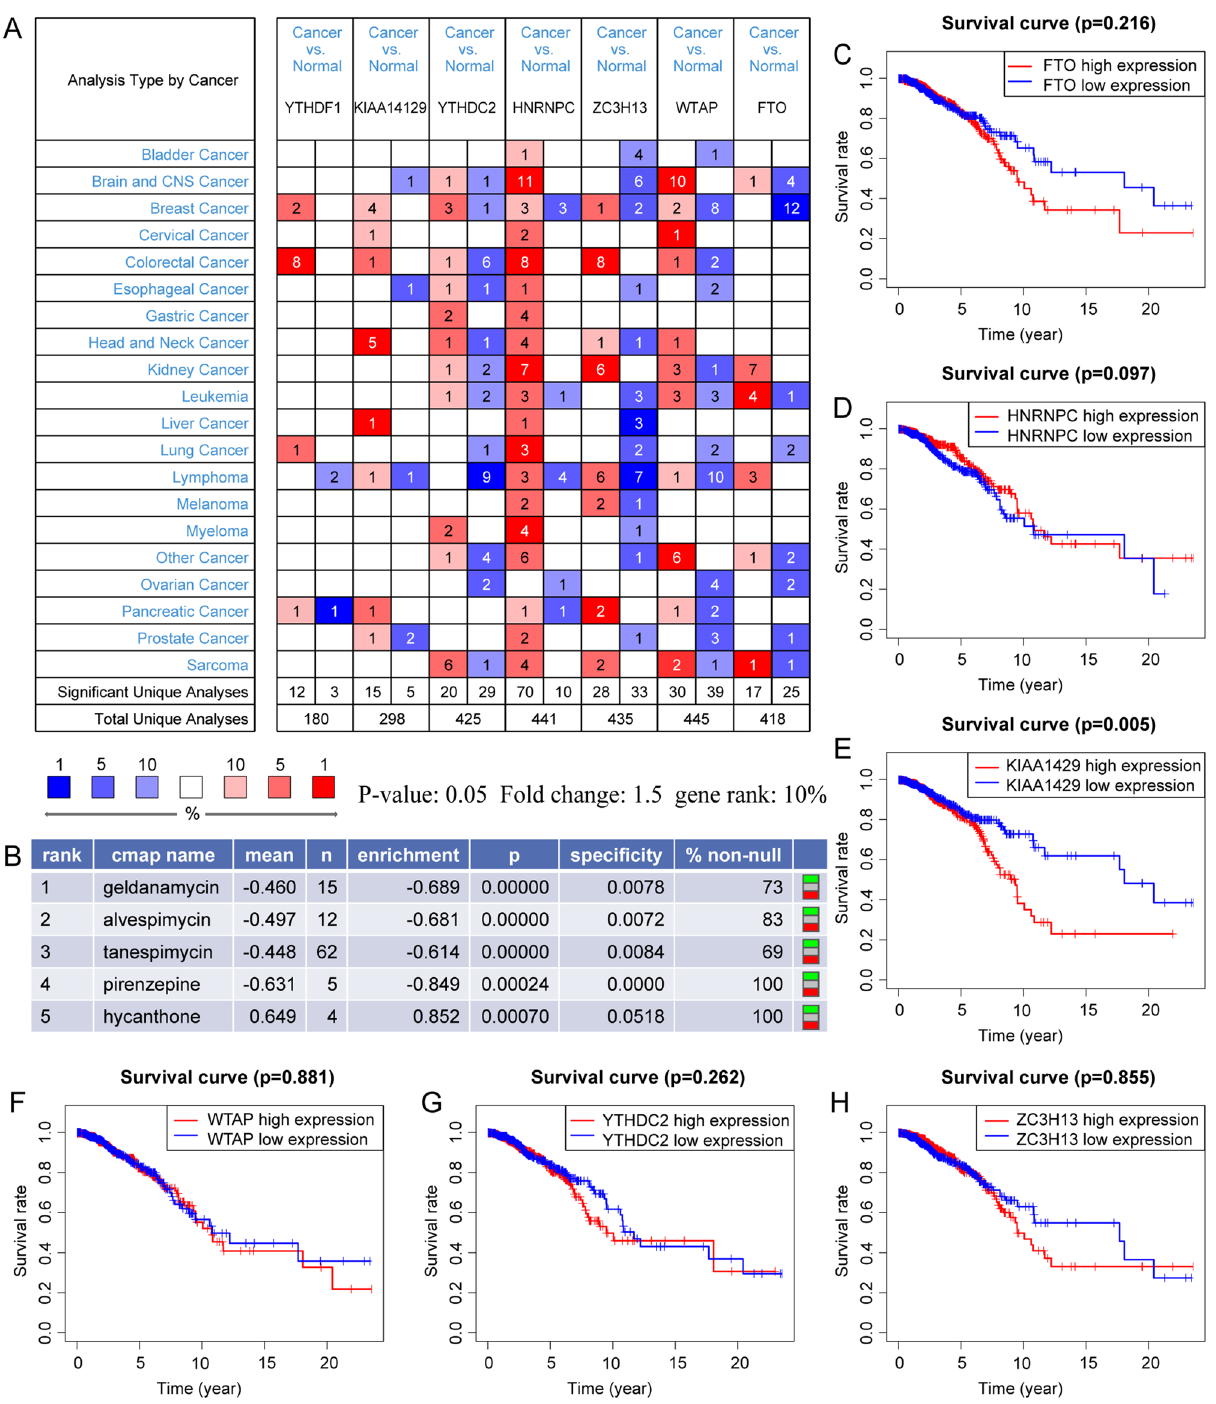
Figure 5. Clinical and pan-cancer characters of m6A regulators. ( A ) The expression of seven prognostic m6A regulator genes of BC in pan-cancer. ( B ) five potential therapeutic drugs predicted by seven m6A regulators in the breast cancer prognostic model. ( C – H ) Survival analysis of m6A regulators. ( C ) FTO. ( D ) HNRNPC. ( E ) KICC1429. ( F ) WTAP. ( G ) YTHDC2. ( H ) ZC3H13. Red represents high expression and blue represents low